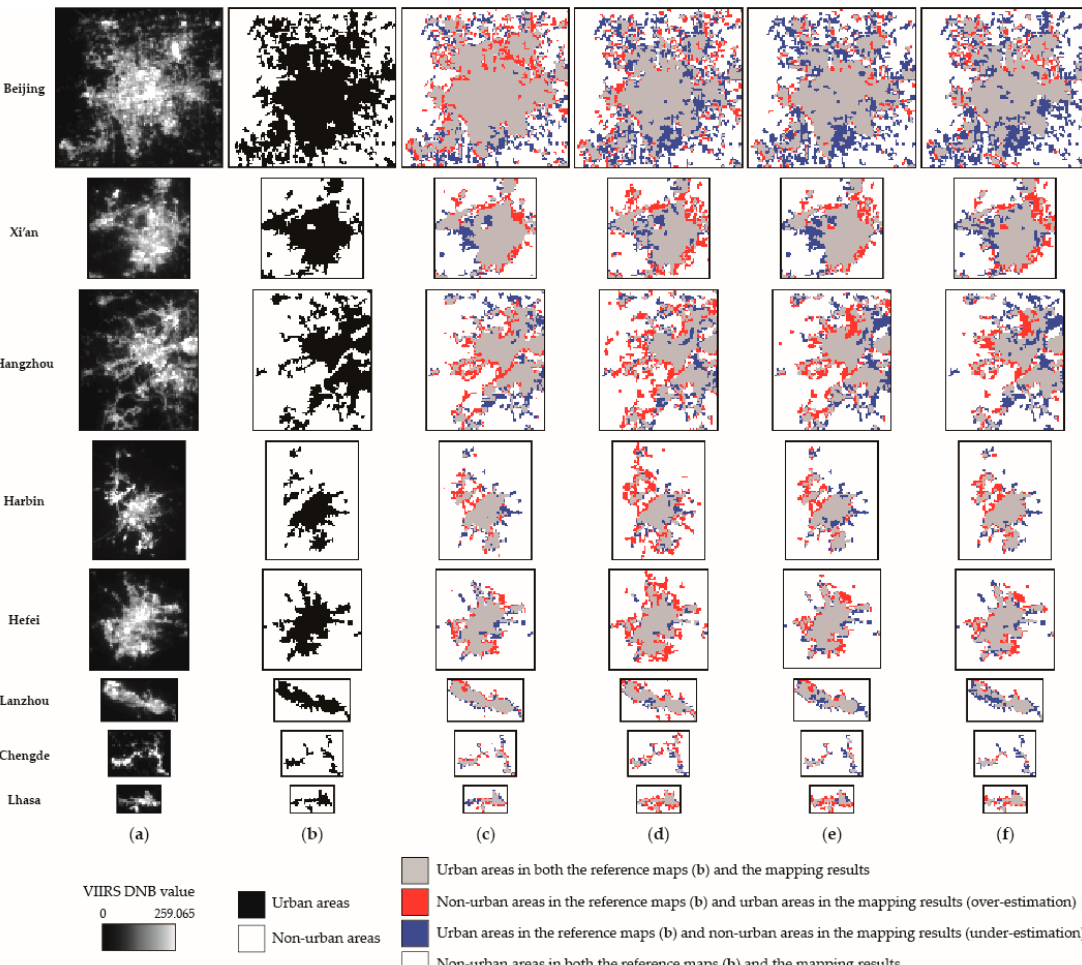
Figure 7. VIIRS DNB images of eight selected reference cities in Test 3 ( a ); 750 m reference urban area maps from Landsat classification ( b ); corresponding urban area mapping results from different methods: results from the city-optimized method ( c ); results from the logistic regression method ( d ); results from the proposed method using ED ( e ) and using MD ( f ). The combined pixels in gray color and in red color are the urban areas generated from different mapping methods.